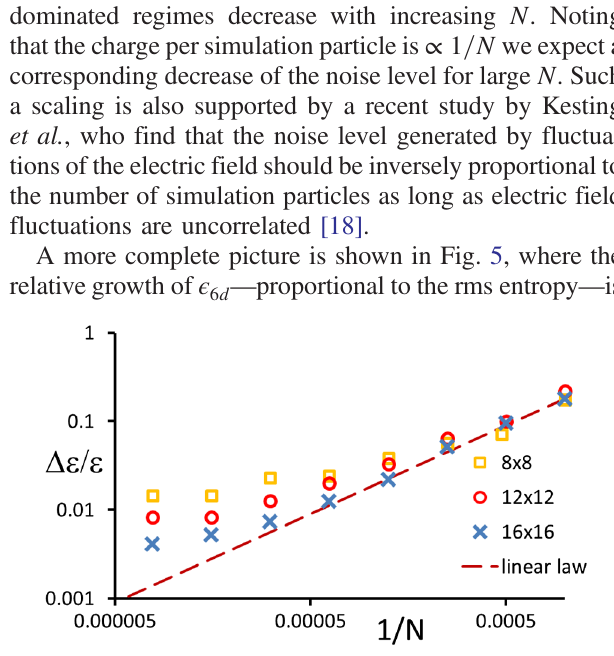
FIG. 5. Relative growth of ϵ 6 d for N from 1000 to 128.000 macro particles indicating transition to grid resolution limited regions